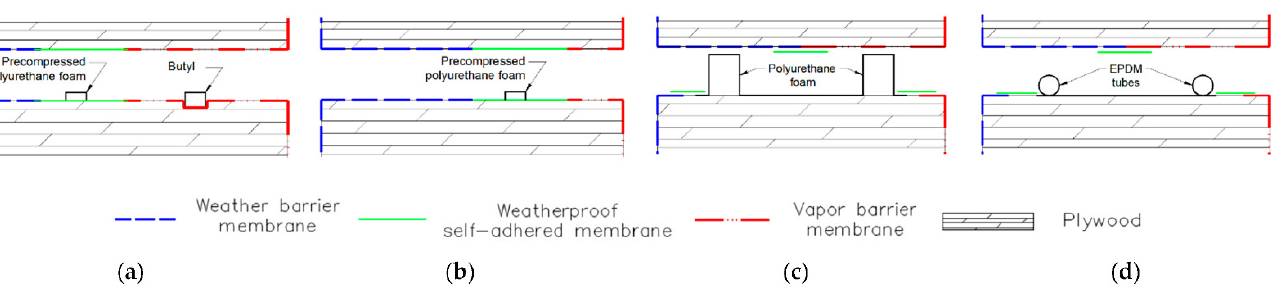
Figure 3. Materials tested in the first sequence: butyl-precompressed polyurethane foam ( a ), precompressed polyurethane foam ( b ), polyurethane foam ( c ), and EPDM tubes ( d ).